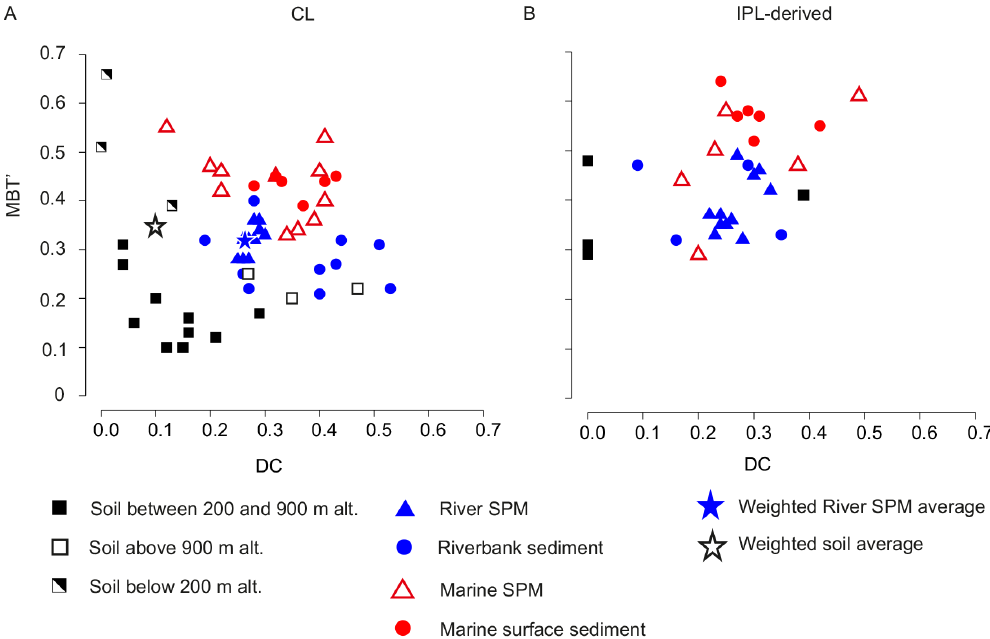
Figure 10. Scatter plots of MBT’ vs. DC for (a) CL and (b) IPL-derived brGDGTs in all sample types and the weighted average MBT’ and DC of the soil and river SPM